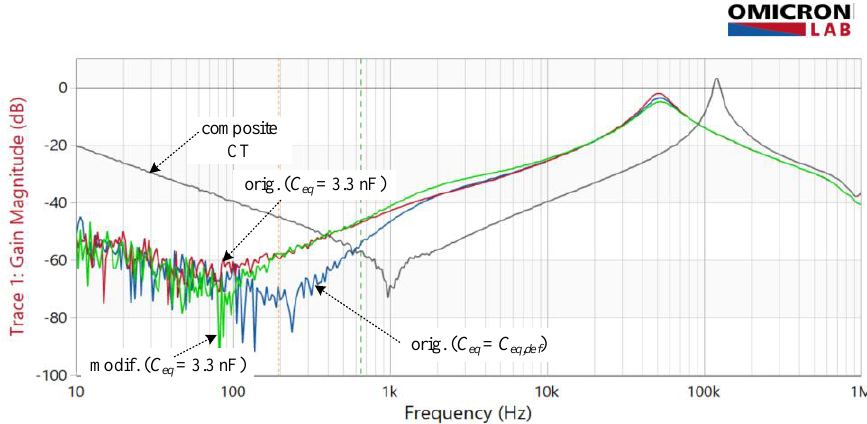
Figure 14. Measured disturbance rejection— H dist of composite CT (grey) vs EECT with original amplifier with default C eq (blue), original amplifier with increased C eq (red) and modified amplifier with increased C eq (green).